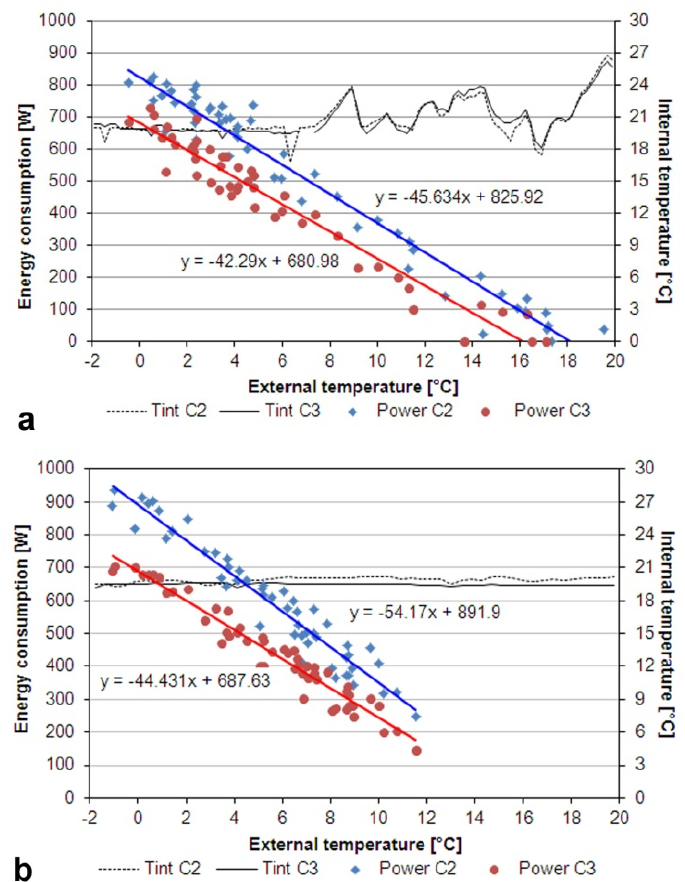
Figure 9. Energy Signature of heating configuration: ( a ) ventilation rate equal to 45 m 3 /h; ( b ) ventilation rate equal to 60 m 3 /h.